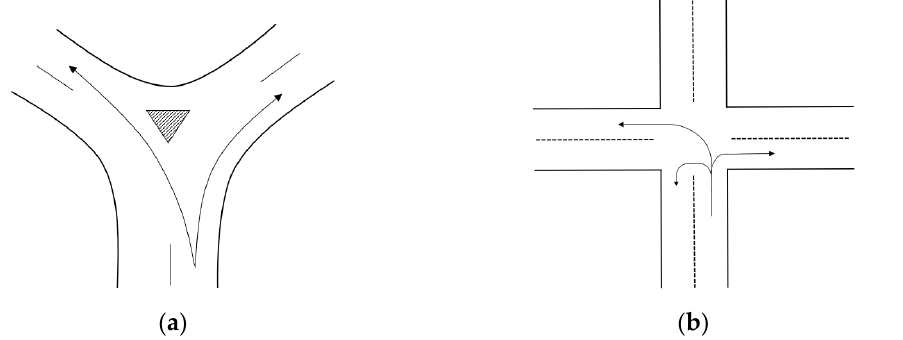
Figure 6. Diagram of turning at different road intersections: ( a ) turns at Y-shaped road intersection; ( b ) turns at cross-shaped road intersection.